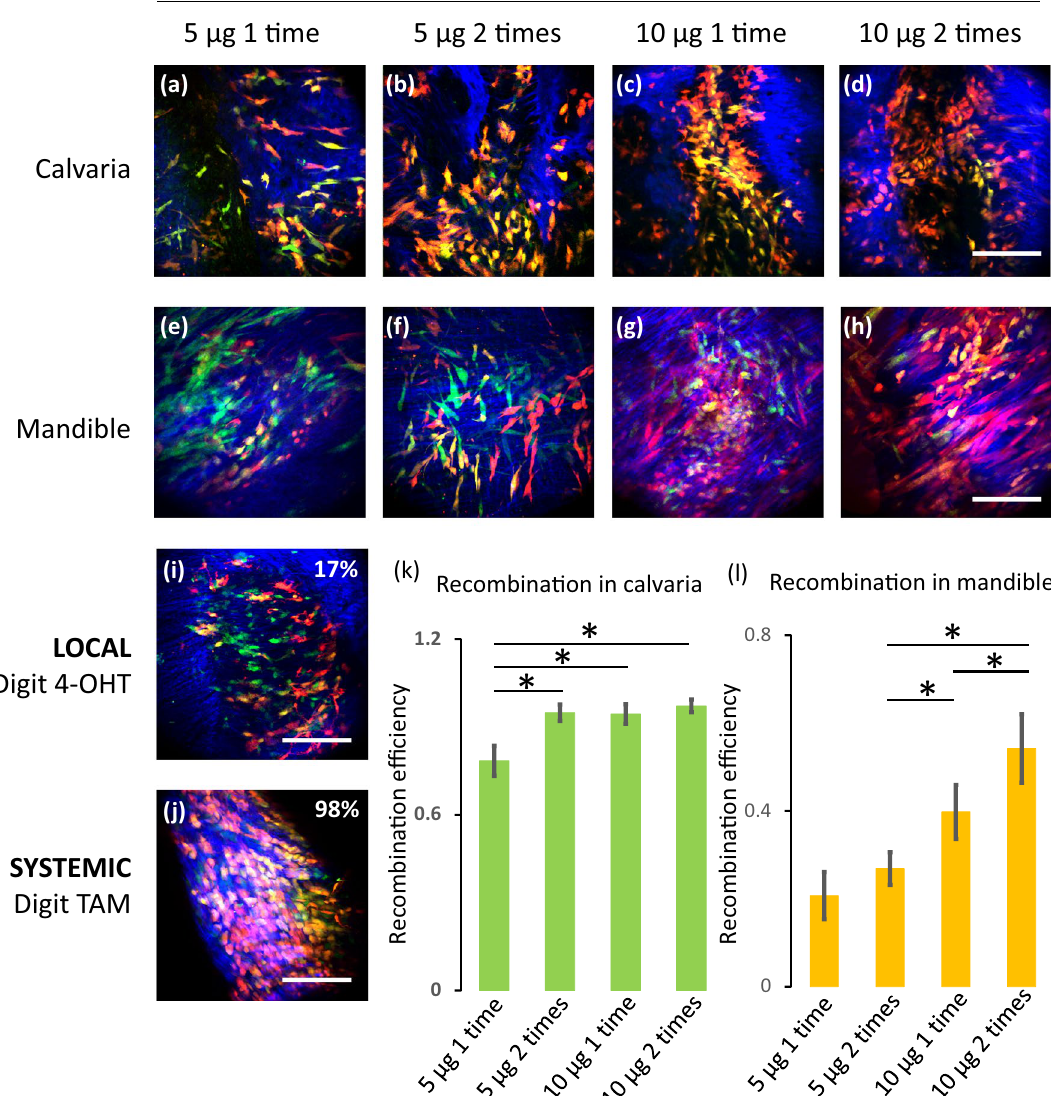
Figure 3. Recombination efficiency in animals treated with different local injection protocols. Representative images are displayed: ( a ) and ( e ) 5 µg 4-OHT local injection for one time in calvaria and mandible; ( b ) and ( f ) 5 µg 4-OHT local injections for two times in calvaria and mandible; ( c ) and ( g ) 10 µg 4-OHT local injection for one time in calvaria and mandible; and ( d ) and ( h ) 10 µg 4-OHT local injections for two times in calvaria and mandible. ( i ) Digit bone of a mouse treated with two local injections of 5 µg 4-OHT. ( j ) Digit bone of a mouse treated with two systemic IP injections of 200 µg of Tamoxifen. The Prx1 (eGFP) expressing cells are shown in green, the tdTomato expressing cells are shown in red and, thus, the eGFP and tdTOMATO co-expressing cells are shown in yellow. Bone is visualized with second harmonic generation and is pseudo-colored in blue. The scale bar represents 100 µm. The recombination efficiency measured in the different treatment groups is shown in ( i ) and ( j ) for the digits (inset numbers) and in histograms for the calvaria ( k ) and the mandibles ( l ). The error bars indicate standard deviations and the * indicates statistically significant difference with a p value < 0.05 (n =